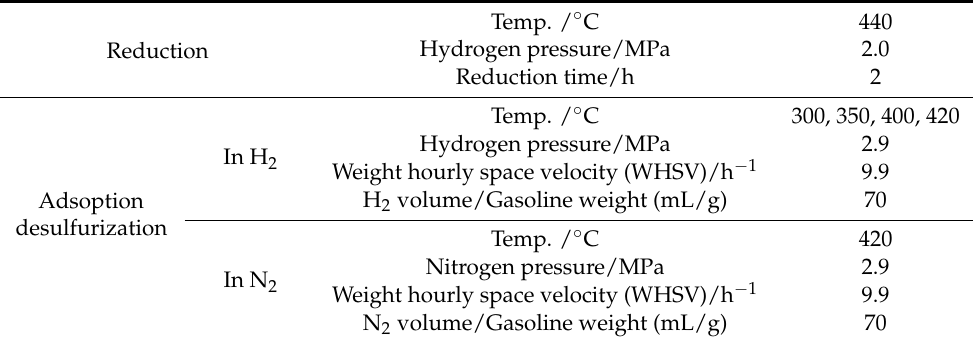
Table 1. Experimental conditions of desulfurization